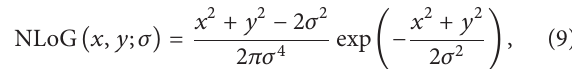
Figure 5: Recursive